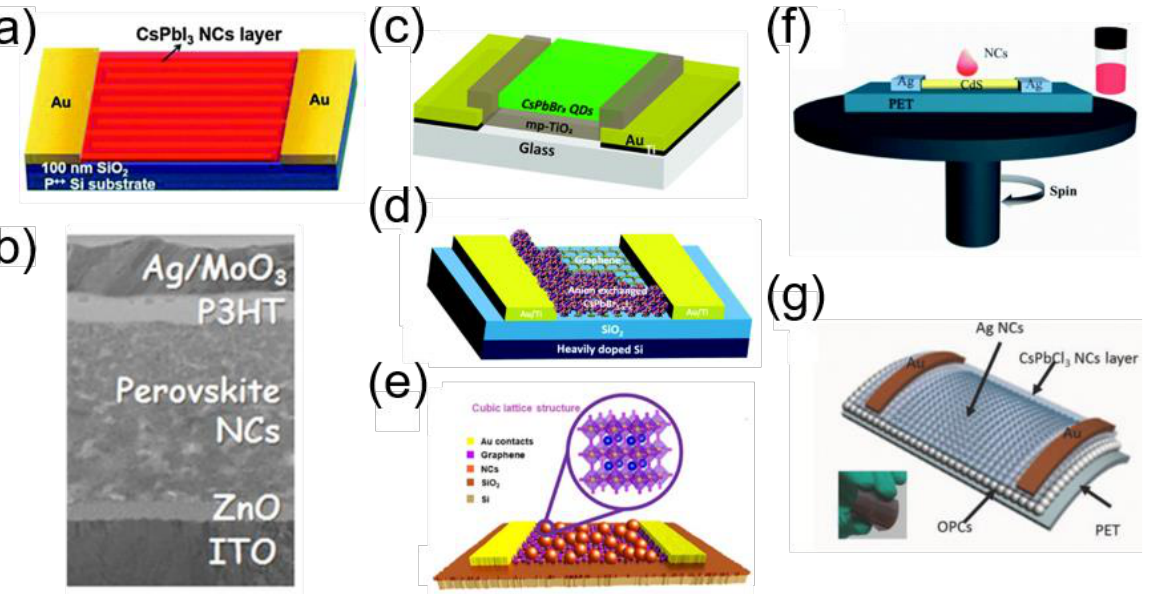
Figure 12. ( a ) Schematic of the CsPbI 3 NCs photodetector (L = 3 mm, W = 7800 mm) [6]. Copyright 2016 Royal Society of Chemistry. ( b ) The cross-section transmission electron microscope image with ZnO as hole blocking layer [76]. Copyright 2018 John Wiley & Sons, Inc. ( c ) Schematic of NC photo-